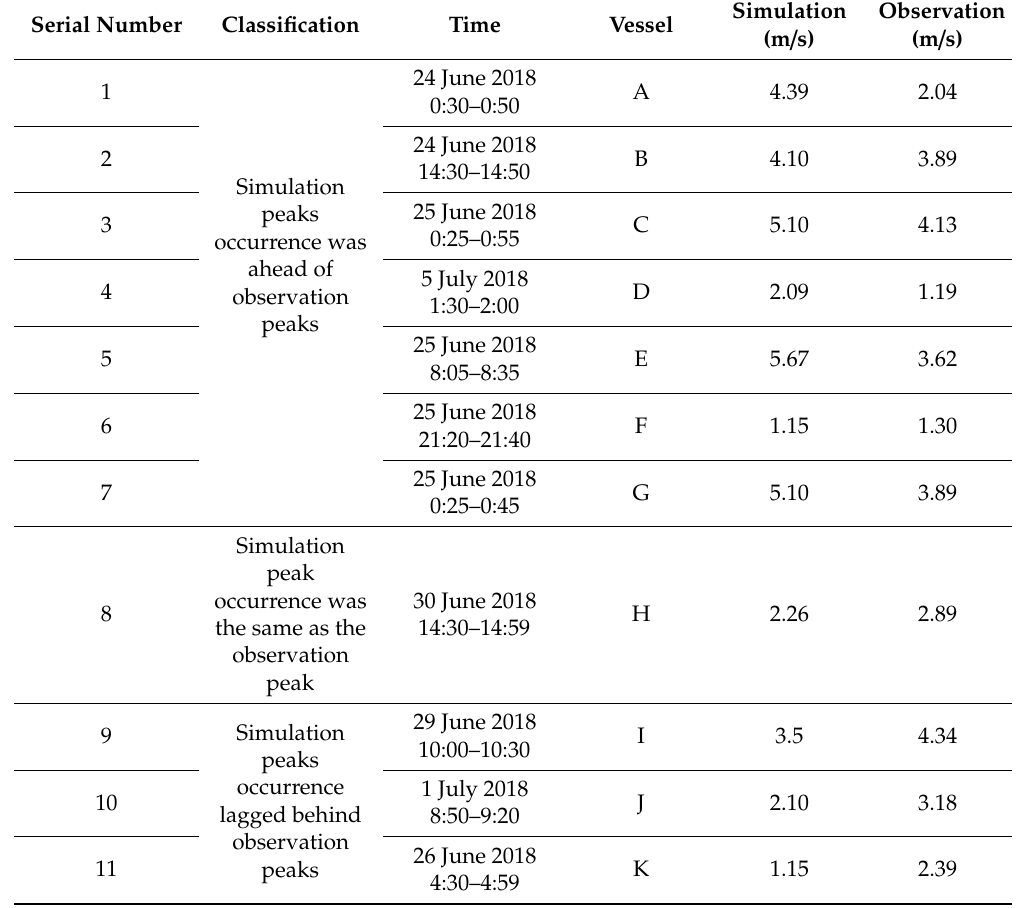
Table 5. Comparison of wind speeds: CALMET and actual